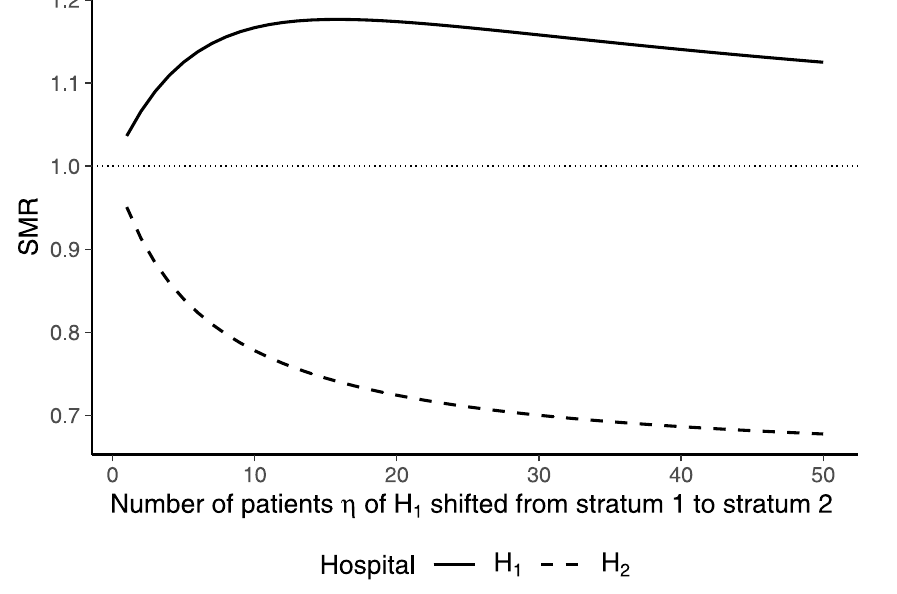
Fig 4. SMRs for different numbers of patients η shifted from stratum 1 to stratum 2 in hospital 1.